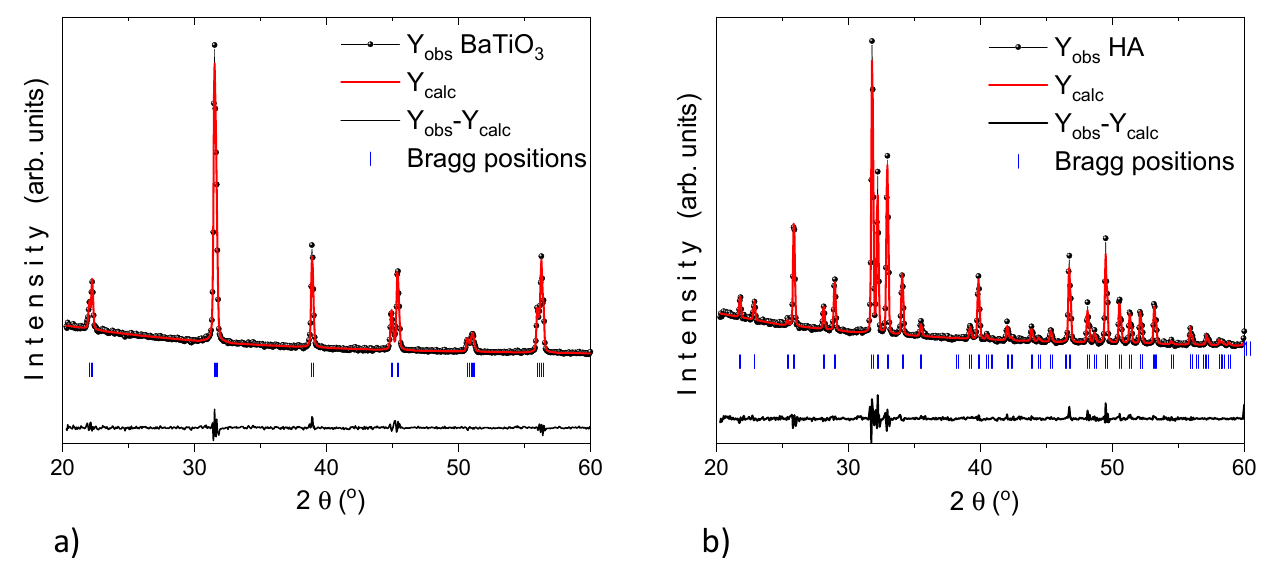
Figure 4. XRD pattern (black dotted line, Yobs) for ( a ) BaTiO 3 and ( b ) HA. Refinement analysis (red solid line, Ycalc) by the Rietveld method using the profile fitting FullProf Suite program. The horizontal (black solid line) represent the residual and the vertical lines (blue solid lines) are the Bragg positions.